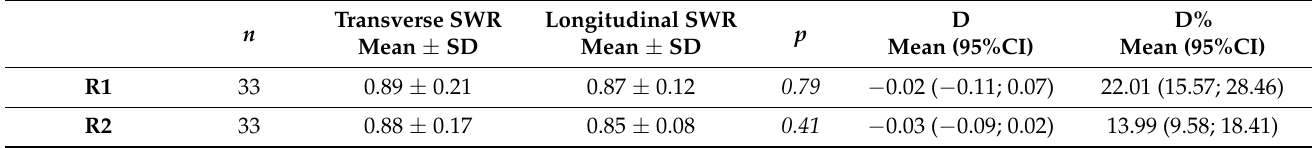
Table 4. Comparison of the SWR values measured in the transverse and longitudinal planes.